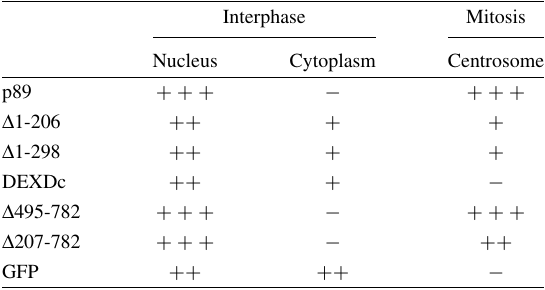
Subcellular localization of the GFP- Δ p89 constructs. Summary of a semi-quantitative analysis of the subcellular localization of the GFP- Δ p89 constructs in interphase and mitosis in living cells. Signal in- tensities: − = none, + = weak, ++ = strong, +++ = very